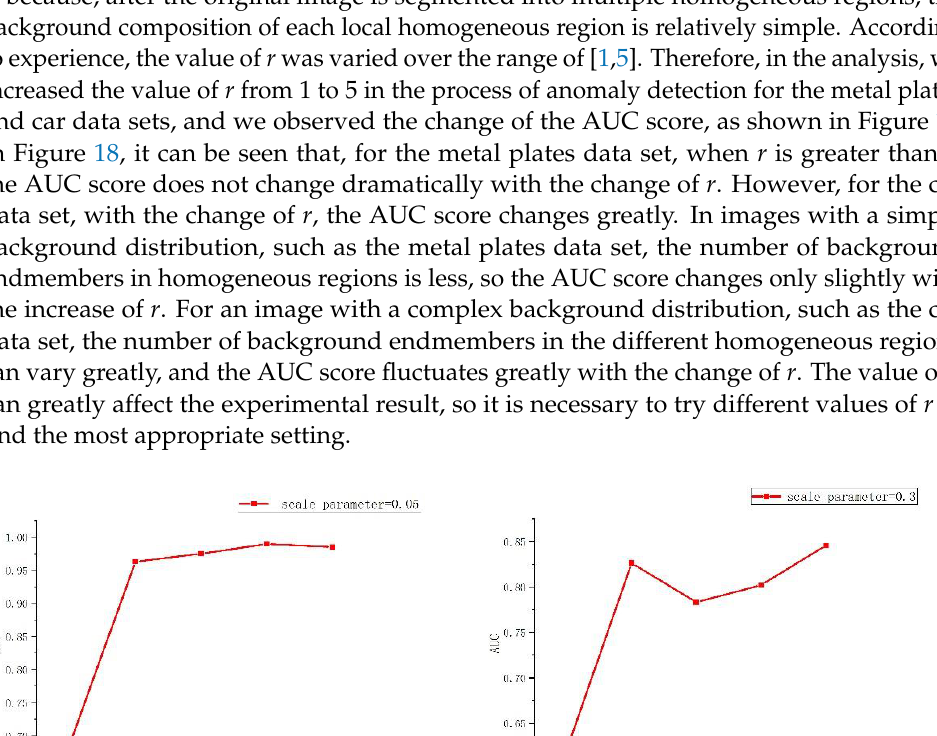
region segmentation has only a limited impact on the detection